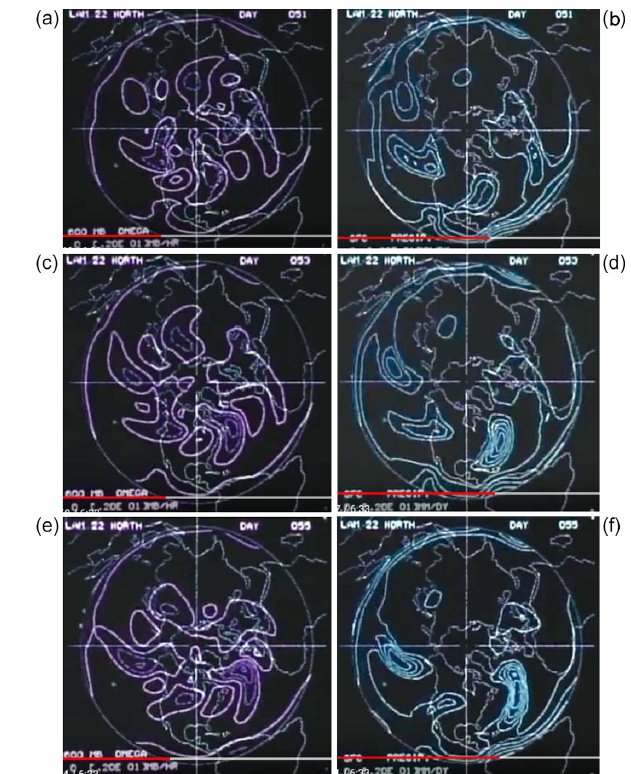
Figure 3. Snapshots from the computer animation showing LAM results at three times near 12Z on days 51 (a, b) , 53 (c, d) , and 55 (e, f) . Panels (a) , (c) , and (e) show the pressure vertical veloc- ity (dashed contours denote negative values, i.e., upward motion), and panels (b) , (d) , and (f) show the precipitation